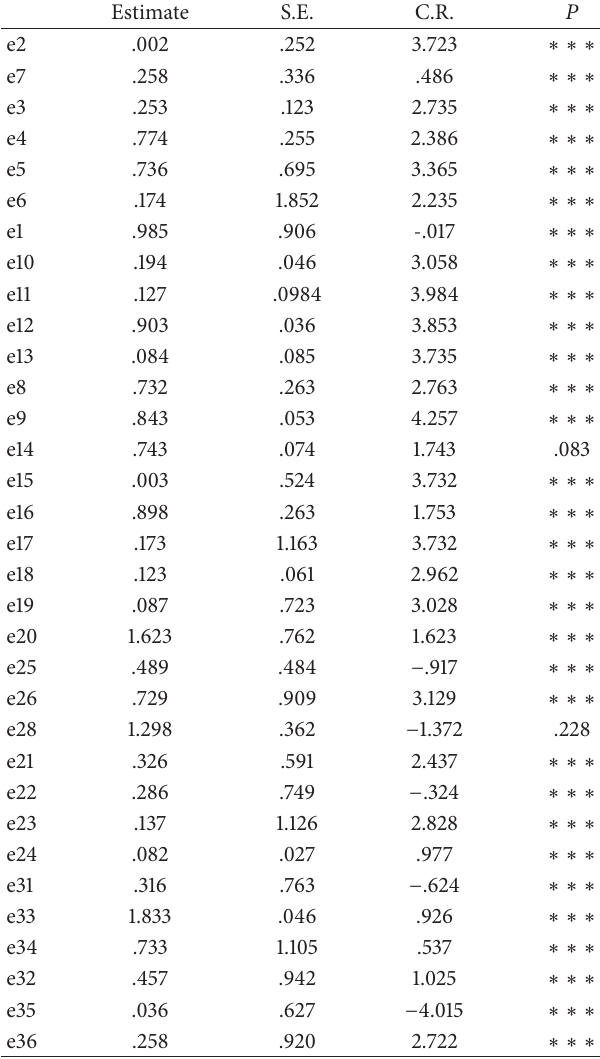
Table 5: Variances estimation results.